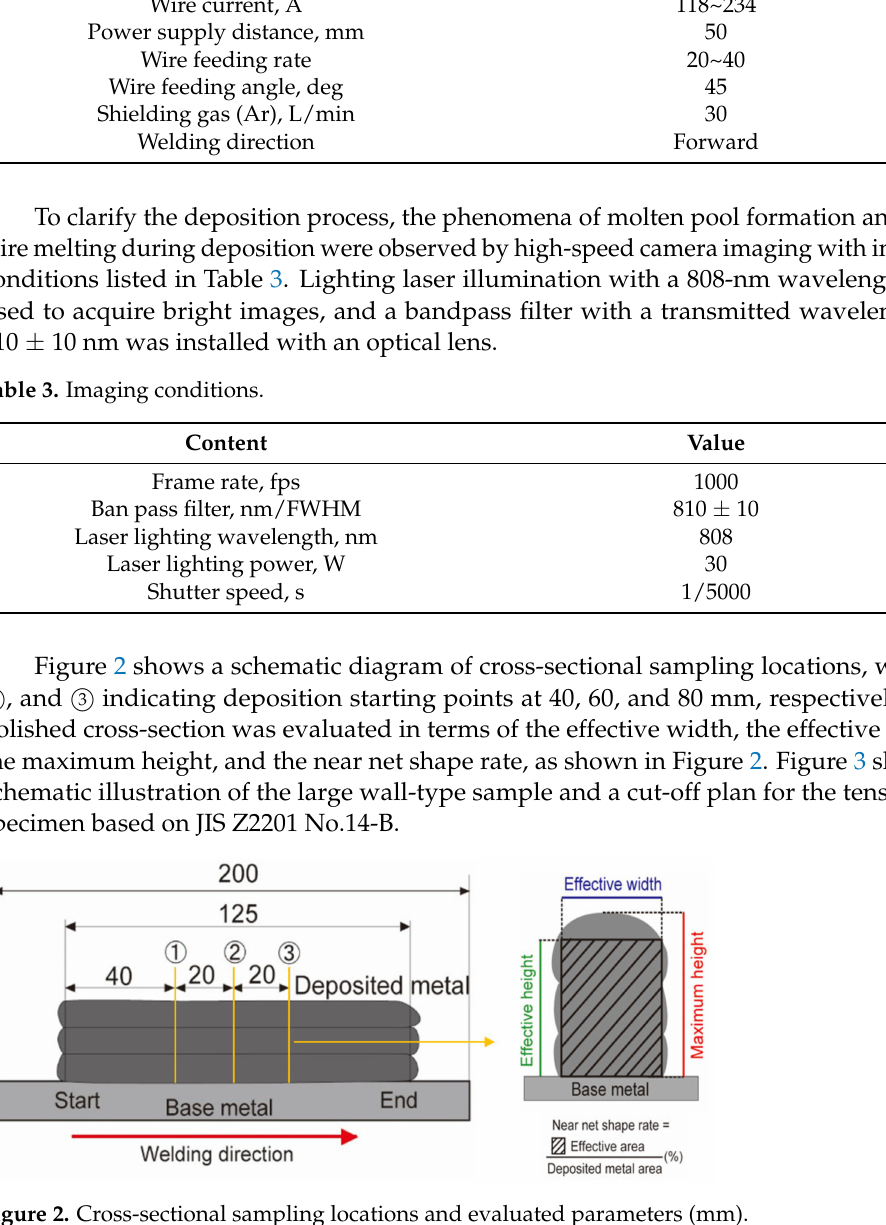
Figure 2. Cross-sectional sampling locations and evaluated parameters